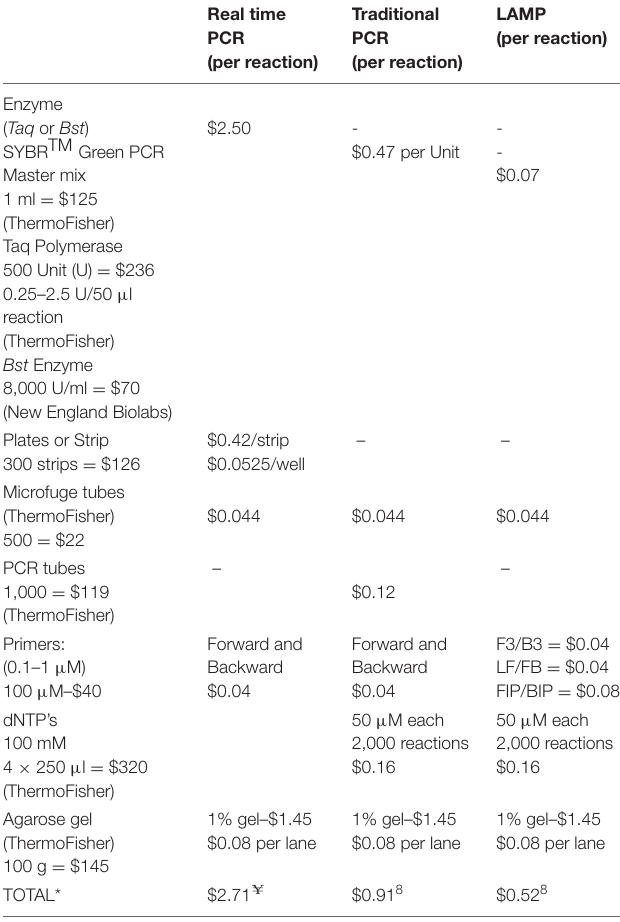
TABLE 3 | Reagent cost comparison between LAMP, PCR, and